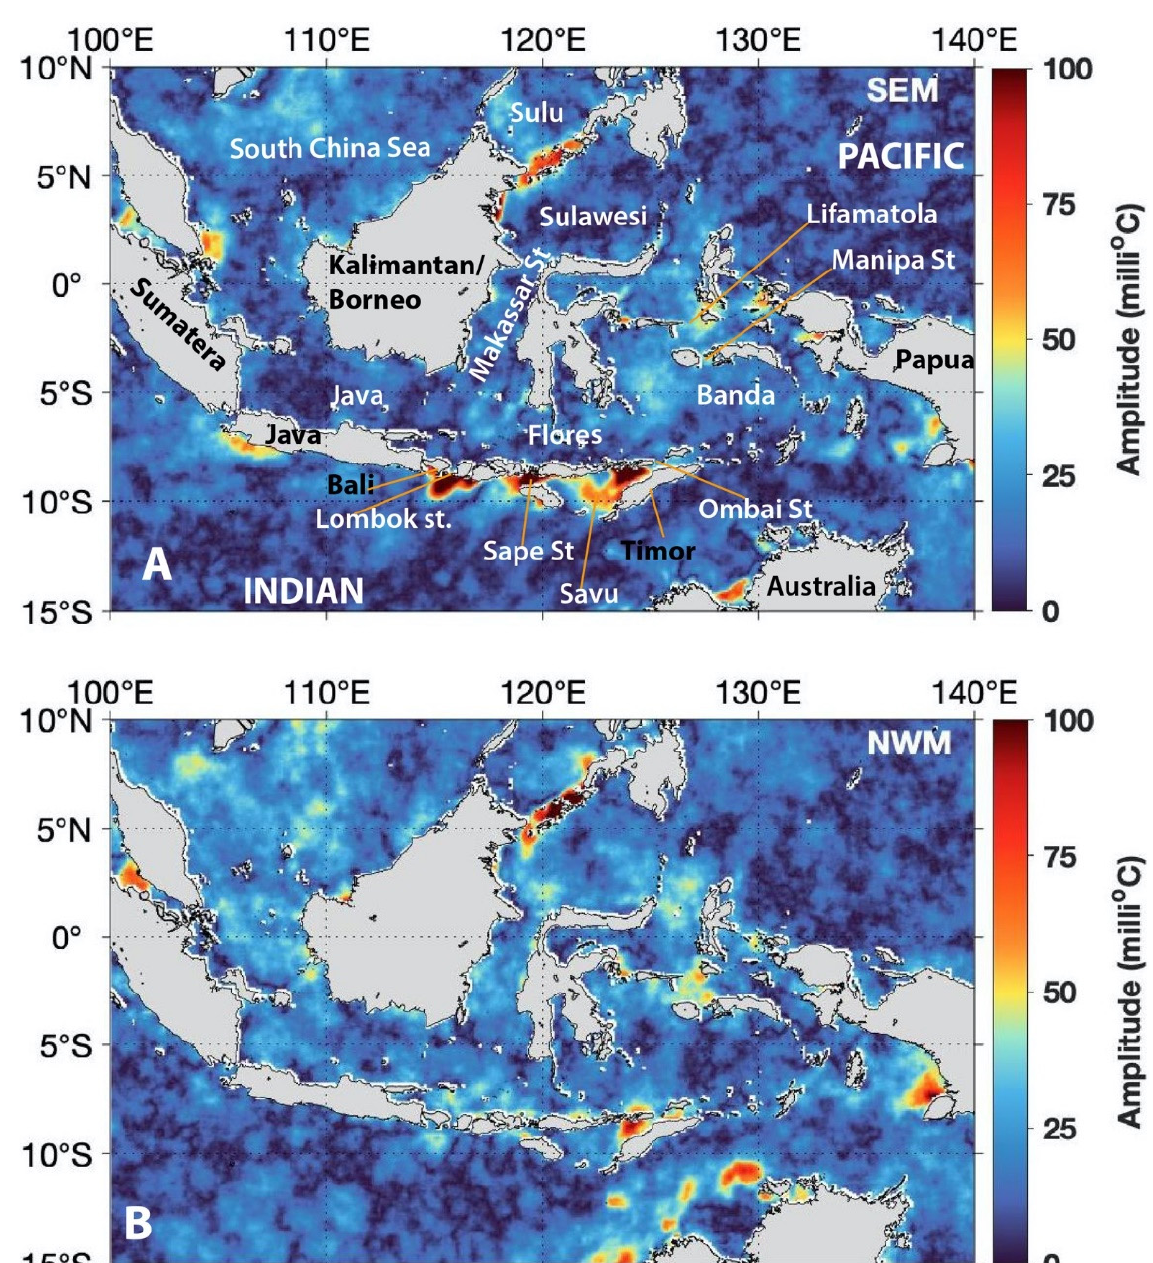
Figure 3. The amplitude of the fortnightly signal (MSf): ( A ) During the southeast monsoon (boreal summer) and ( B ) during the northwest monsoon (boreal winter). The tidal mixing signatures are more robust/stronger during the boreal summer (when the ITF is generally stronger) than that during boreal